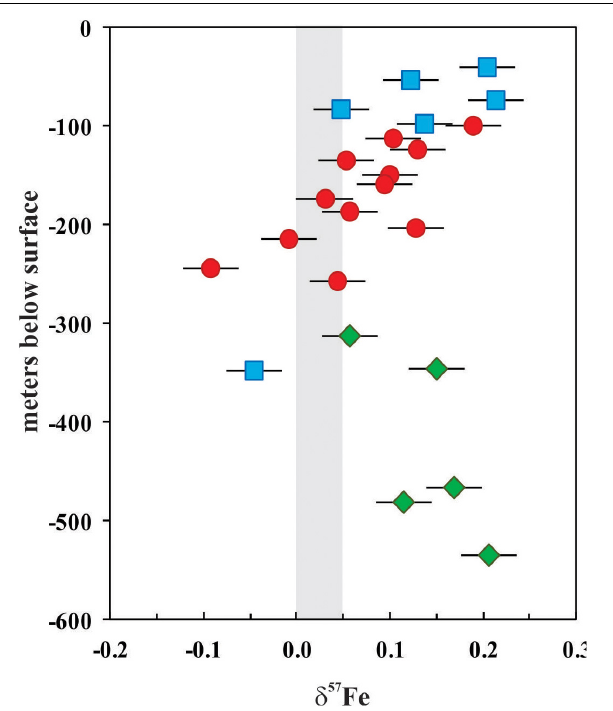
FIGURE 3 | Depth profile of Fe isotopes in whole rocks from the Windimurra Upper Zone drill cores. The respective depth of the samples is based on the correlation of drill